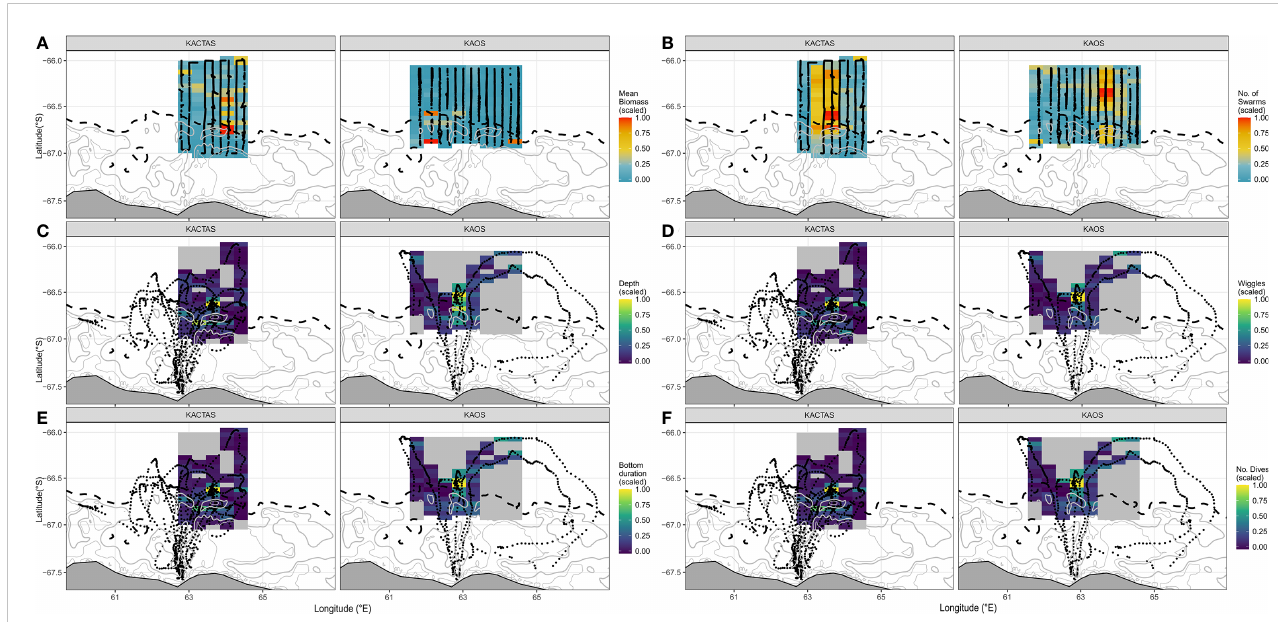
FIGURE 2 Maps displaying the distribution of krill metrics (mean biomass and number of swarms) and four penguin diving metrics (depth, wiggles, bottom duration and # of dives) over the KACTAS and KAOS survey area. Grid cell metrics are binned at a 0.05 ˚ latitude x 0.38 ˚ longitude spatial resolution. The black points represent krill transect (A, B) and penguin tracking observations for krill and penguin plots (C – F) , respectively. Maps displayed illustrate spatially grided predator-prey data, as inputed into models. Land and bathymetric features are displayed as per Figure 1.